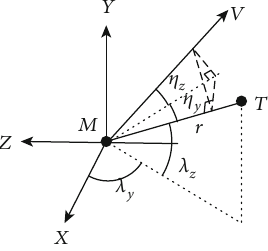
Figure 5: Three-dimensional homing engagement geometry.